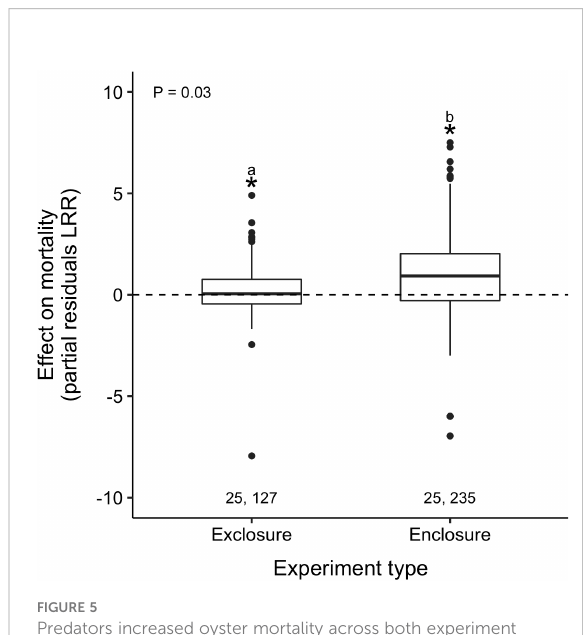
FIGURE 5 Predators increased oyster mortality across both experiment types, but effects were strongest in enclosures when oysters were con fi ned with known predators. Pairs of numbers, boxplots, asterisks, letters, and p-value as in Figure